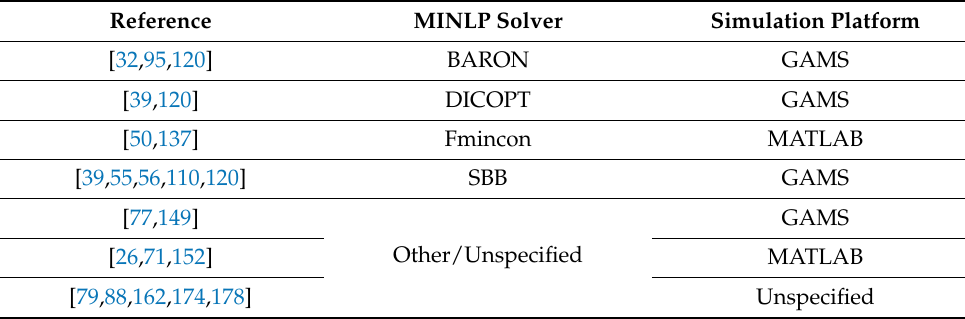
Table 8. Solvers and simulation platforms employed in NLP.